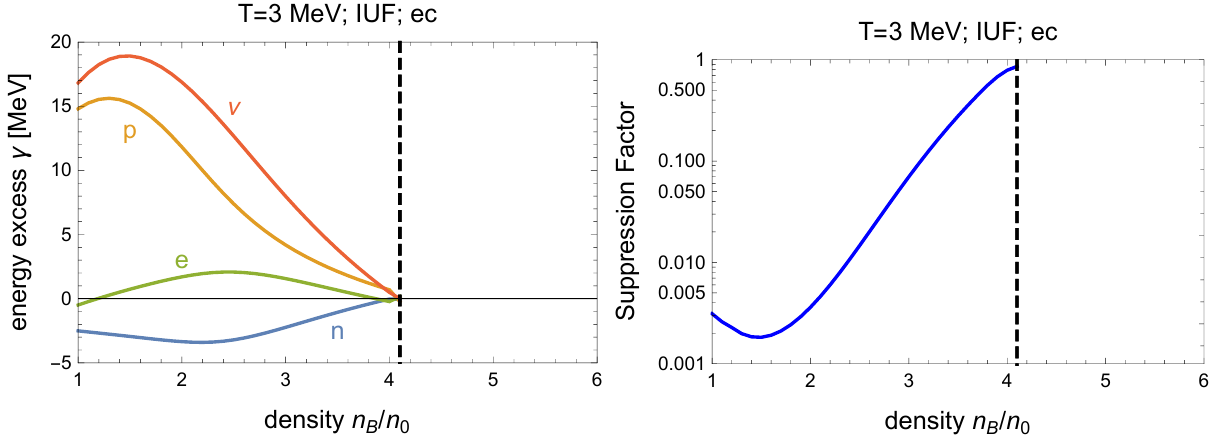
Figure 12. The optimal kinematics for electron capture for the IUF EoS. Left panel : the least suppressed kinematic arrangement, showing the energy distance γ of each particle from its Fermi surface. Right panel : the overall Fermi-Dirac suppression factor, e −| γ p | / T e −| γ e | Θ ( γ e ) / T e −| γ n | Θ ( − γ n ) / T , which is dominated by the difficulty of finding a proton at energy γ p above its Fermi surface.